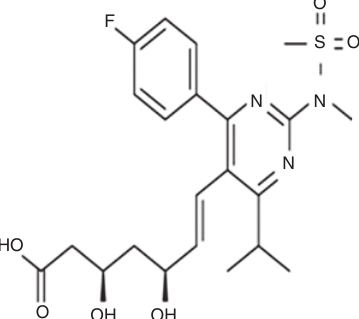
Figure 1: Chemical structure of